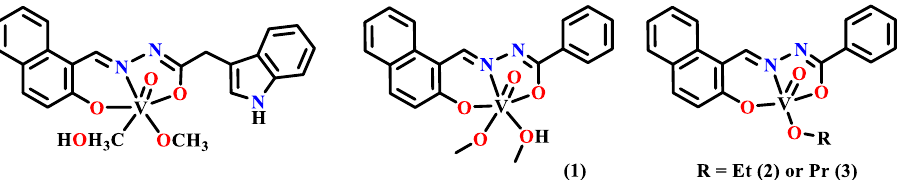
Figure 8. The new binuclear nickel(II) complex bridge coordinated by a special dihydrazone linked by oxamide. 2.1.2. The Second and Third Transition Metal Complexes of Naphthylhydrazone with Antibacterial Activities Early in 2008, R. Prabhakaran et al. [58] synthesized and characterized three palla- dium(II) complexes of 2-hydroxynaphthylhydrazone (phenylhydrazone was also in- volved) containing N -substituted thiosemicarbazide as a side chain (Figure 9). In each complex, the ligand was also coordinated with the central Pd(II) via the O / N / S -tridentate coordination mode. By comparing the in vitro antibacterial activity of these complexes, it was found that the activity of N -phenyl-substituted hydrazone Pd(II) complex 2 was sig- nificantly higher than that of N -methyl-substituted hydrazone Pd(II) complexes 3 and 1 , so the overall antibacterial activity order was as follows: 2 > 1 > 3 . These results indicated that the different ligand substituents could significantly affect the overall antibacterial ac- tivity of the complexes. For complex 2 , the authors also discussed the possible SAR, sug- gesting that its high activity was related to the co-existence of two electron-withdrawing groups, naphthalene and benzene, and the chelation of the hydrazone ligand also greatly reduced the polarity of the central metal ions and increased the lipophilicity, which was